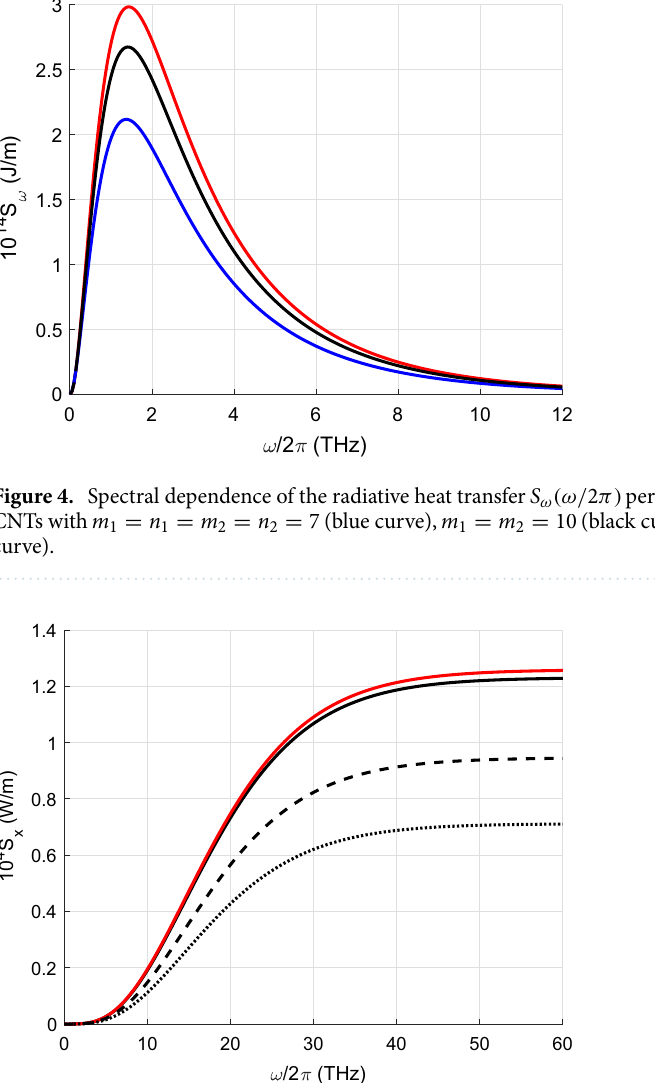
Figure 5. Radiative heat transfer per unit length S x versus frequency for m 2 13 whereas the red one is obtained when scattering is not considered. The dashed line is corresponds to m 1 = 10 , and the dotted line for m 1 obtained for m 1 =